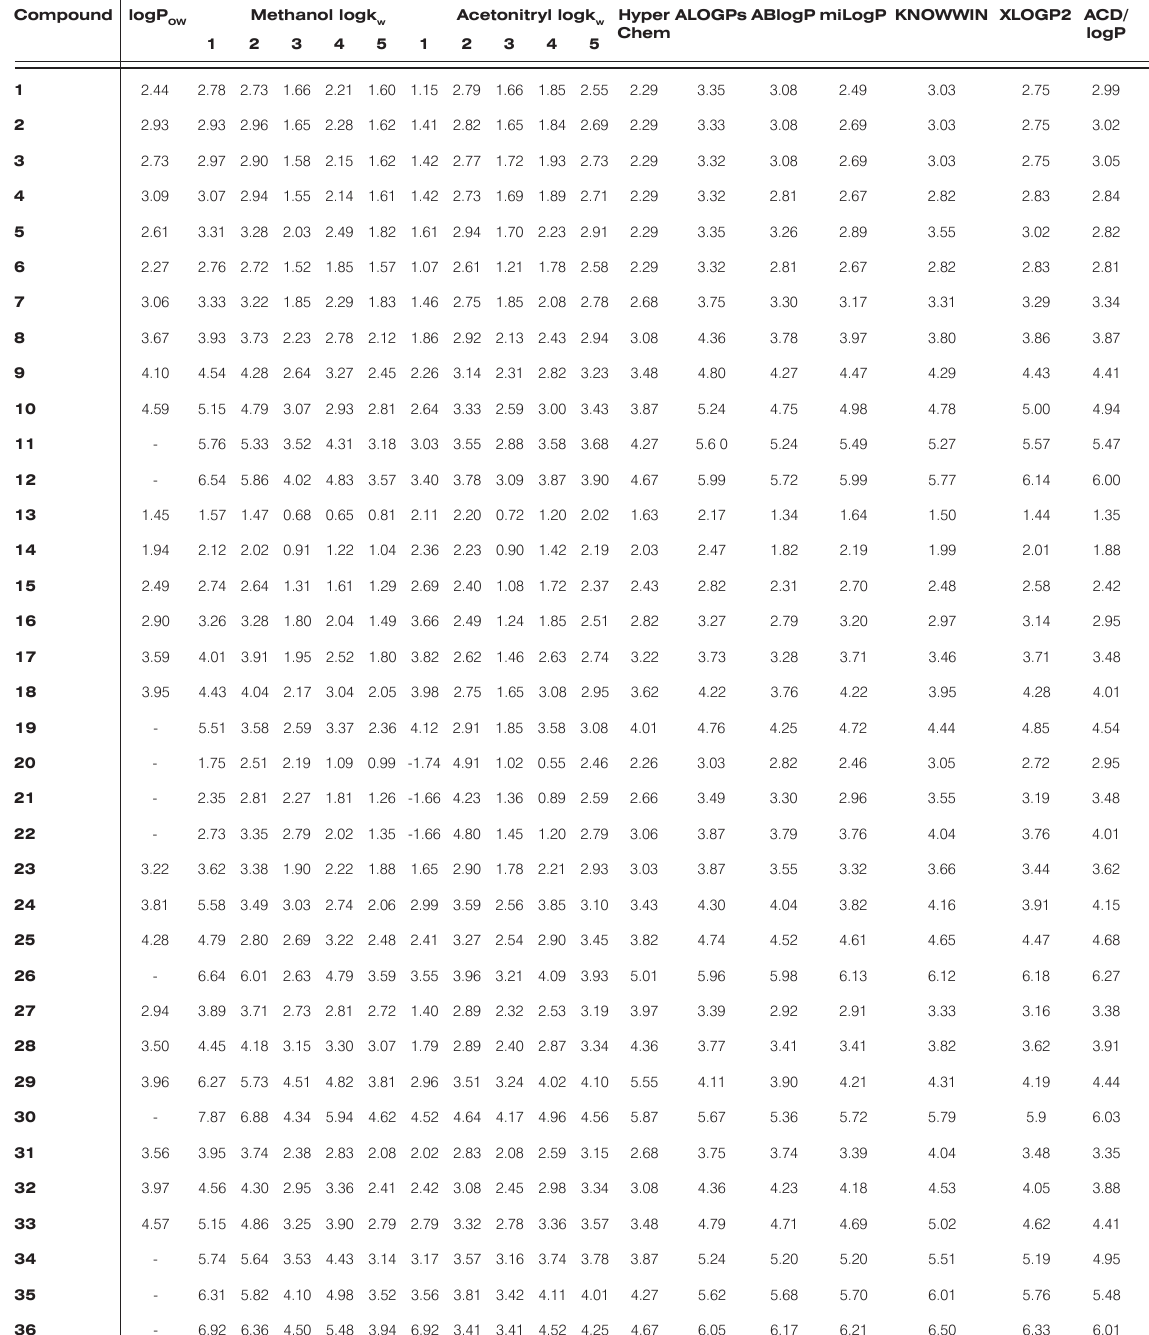
Table 2. Lipophilicity parameters determined by experimental, chromatographic and theoretical methods. Compound logP